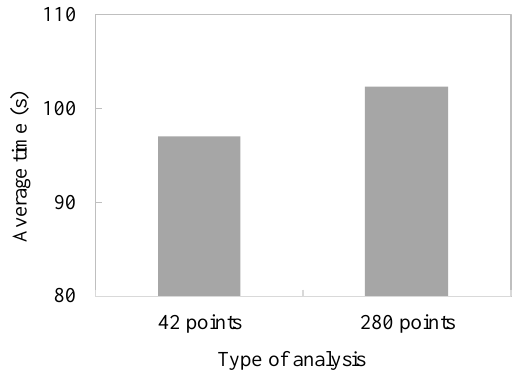
Figure 18. Computational time comparison for the PDM simulations with TP and expanded TP.